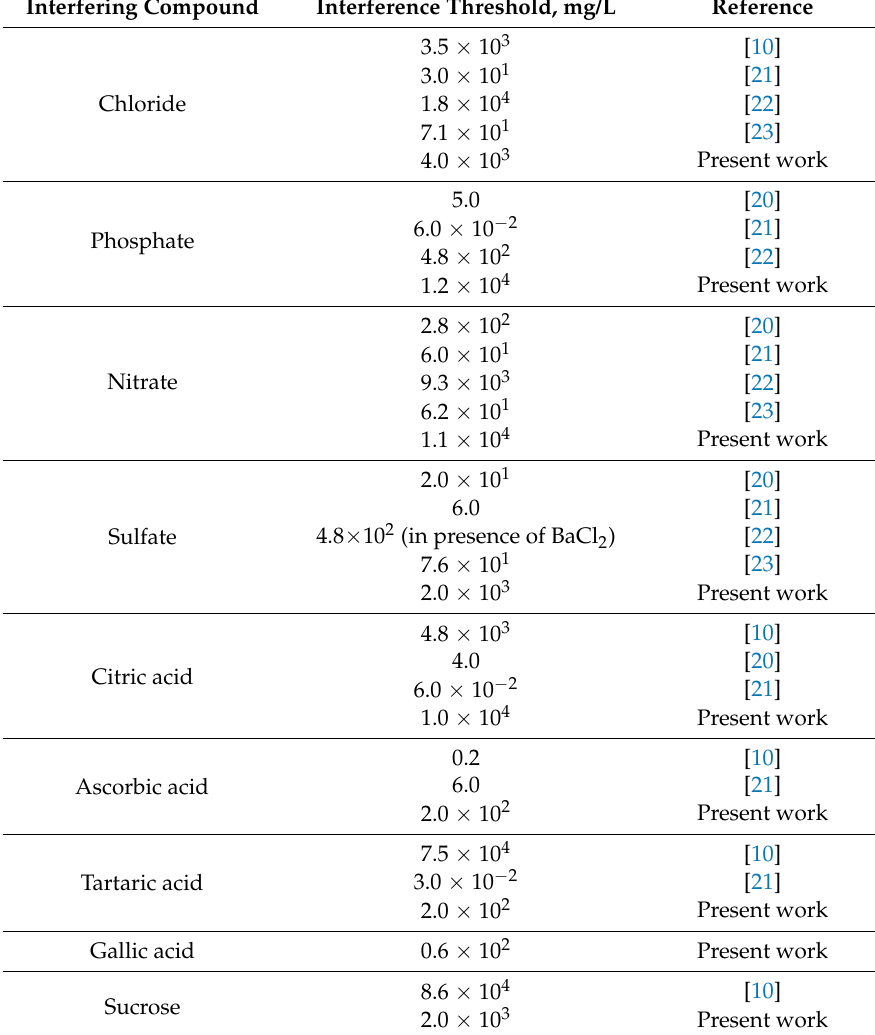
Table 3. Interference thresholds for different spectroscopic methods for oxalate